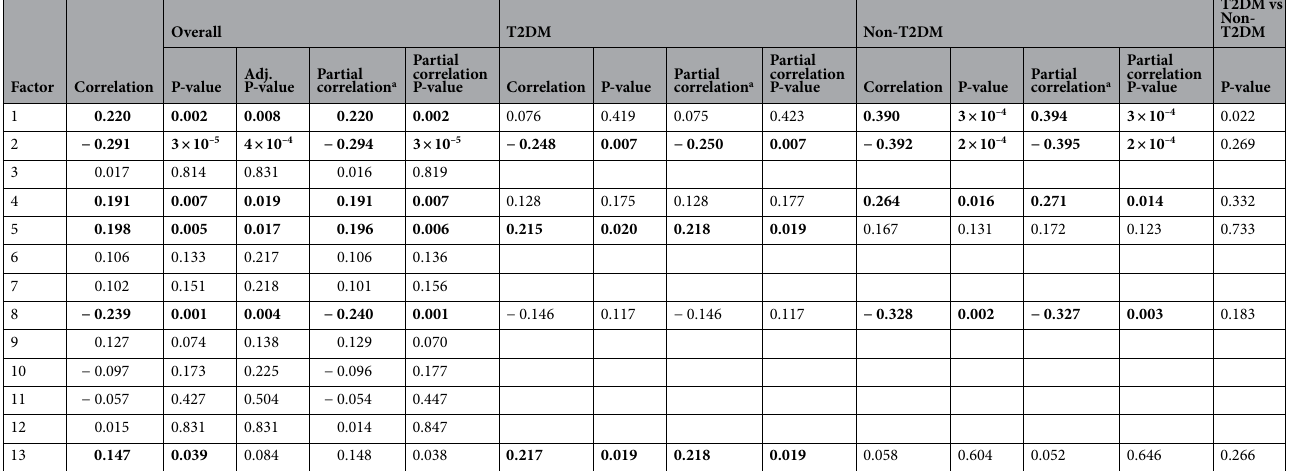
Table 2. Spearman correlation analyses between 90-day change in metabolite factor level and 90-day change in NT-proBNP. Significant values are in bold. a Partial correlations adjusted for treatment assignment.